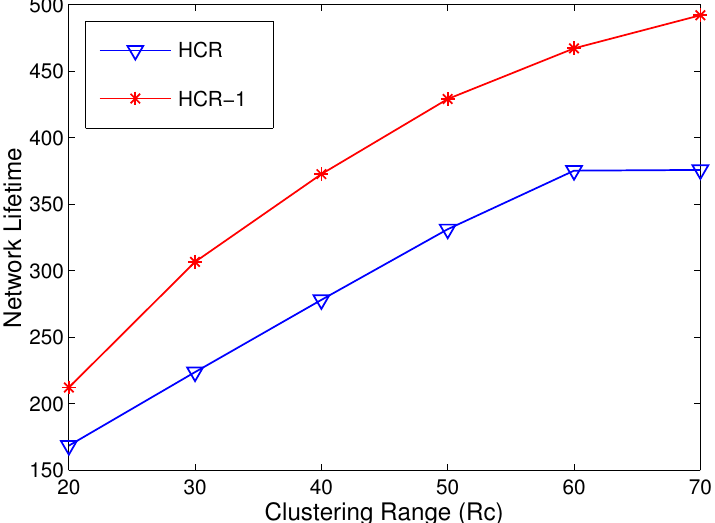
Figure 9. Network lifetime comparison with different R